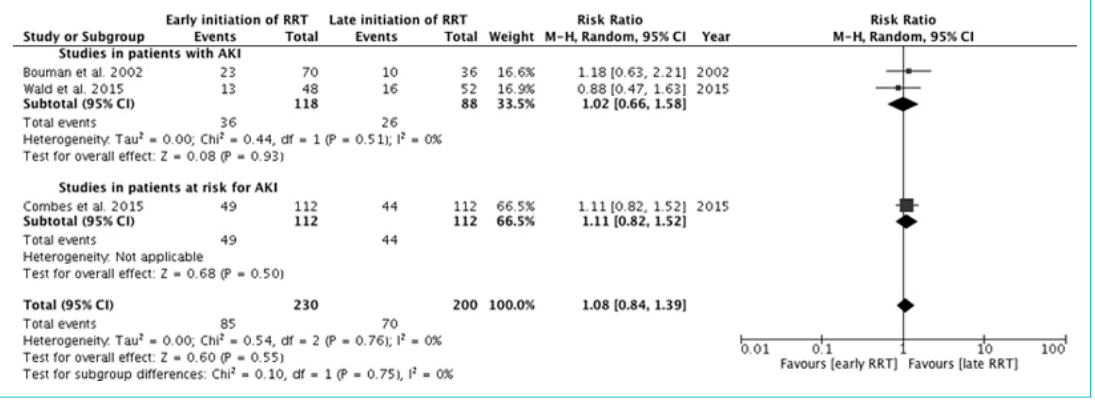
Figure S3: Intensive care unit mortality. Forest plot demonstrating the impact of early or preventive renal replacement therapy on intensive care unit mortality compared with late renal replacement therapy. Data are presented as risk ratios with 95% confidence intervals. A random- effects model was used.